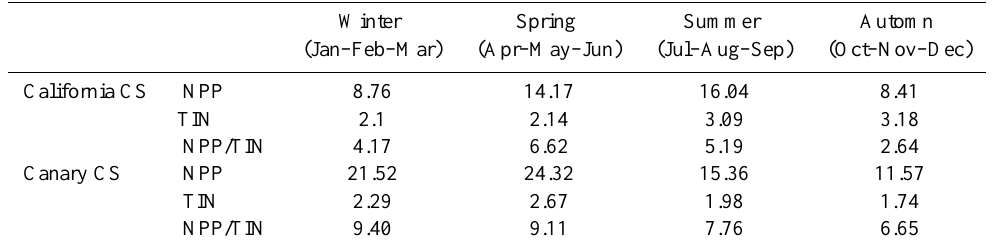
Table 4. Seasonally averaged NPP (molCm − 2 yr − 1 ), TIN (molCm − 2 ) and nutrient assimilation rate (i.e., NPP/TIN in yr − 1 ) in the euphotic zone in the California CS and Canary